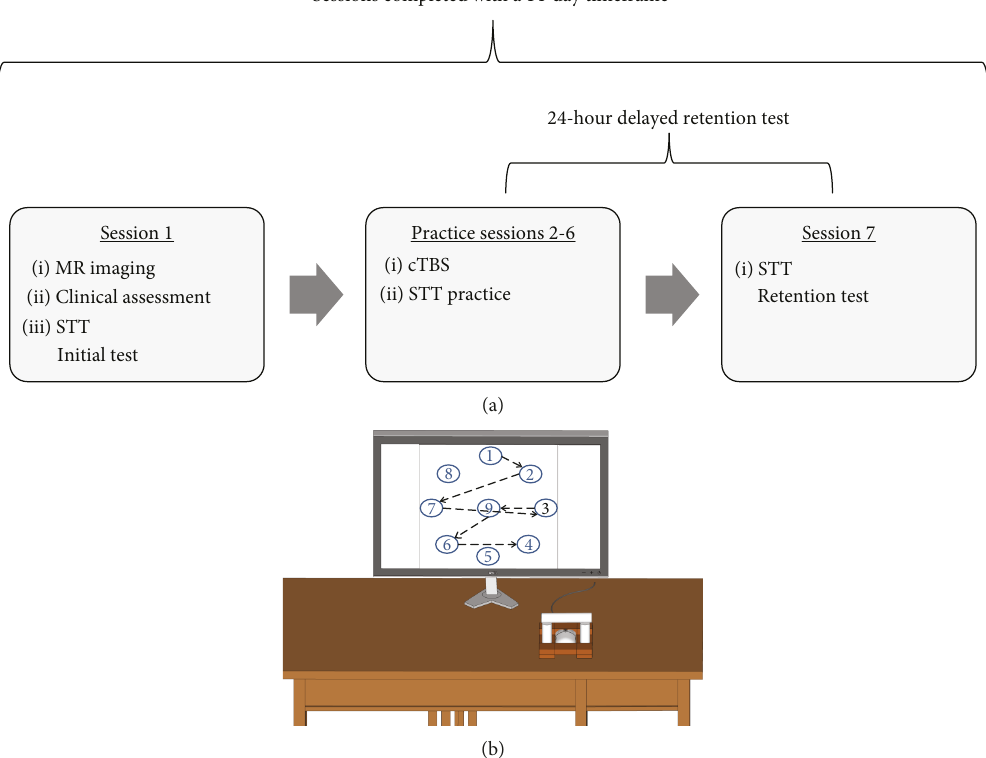
Figure 1: Experiment design and apparatus. (a) Experimental design and (b) serial tracking task (STT) apparatus and target